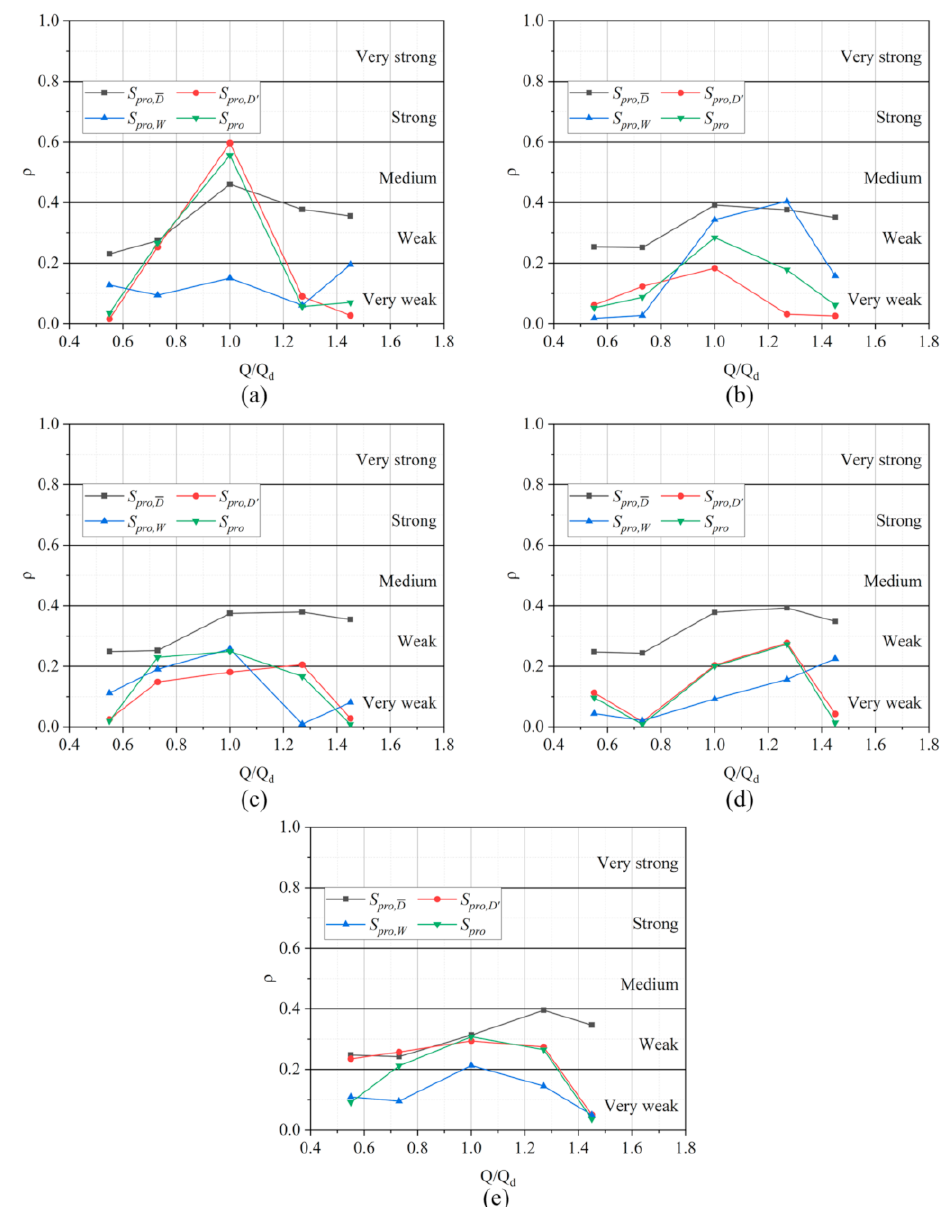
Figure 20. Correlation between transportation effect and entropy production. ( a ) impeller1, ( b ) im‑ peller2, ( c ) impeller3, ( d ) impeller4, ( e )